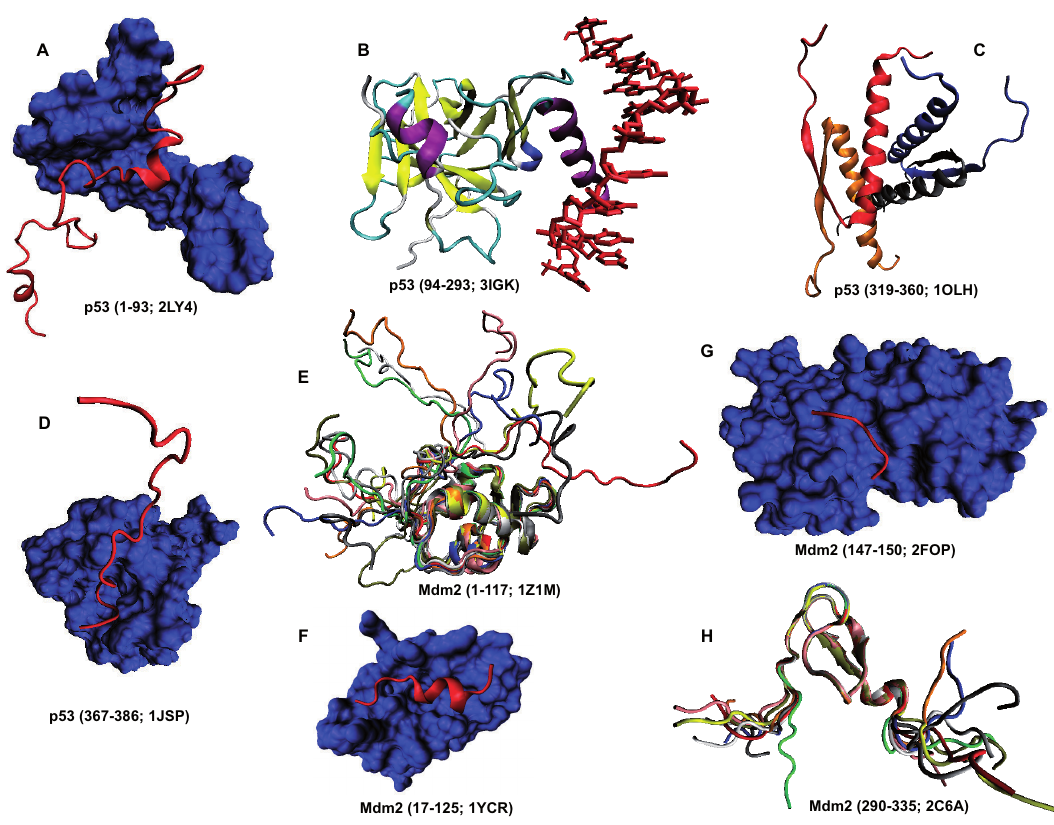
Figure 14. Structural characterization of human proteins involved in the p53-mediated apoptotic signaling pathways: group IV. A . Residues 1–93 of p53 (red ribbon) in a complex with the bromodomain of CREB-binding protein (blue surface) (PDB ID: 2LY4); B . Residues 94–293 of p53 in a complex with DNA (red bonds) (PDB ID: 3IGK); C . Residues 319–360 of p53 in a homotetrameric complex (PDB ID: 1OLH); D . Residues 367–386 of p53 (red ribbon) in a complex with the bromodomain of CREB-binding protein (blue surface) (PDB ID: 1JSP); E . Residues 1–117 of MDM2 (PDB ID: 1Z1M); F . Residues 17–125 of MDM2 (blue surface) in a complex with the transactivation domain of p53 (residues 15–29, red ribbon) (PDB ID: 1YCR); G . Residues 147–150 of Mdm2 (red ribbon) in a complex with the N-terminal domain of HAUSP/USP7 (blue surface) (PDB ID: 2FOP); H . Residues 290–335 of Mdm2 (PDB ID: